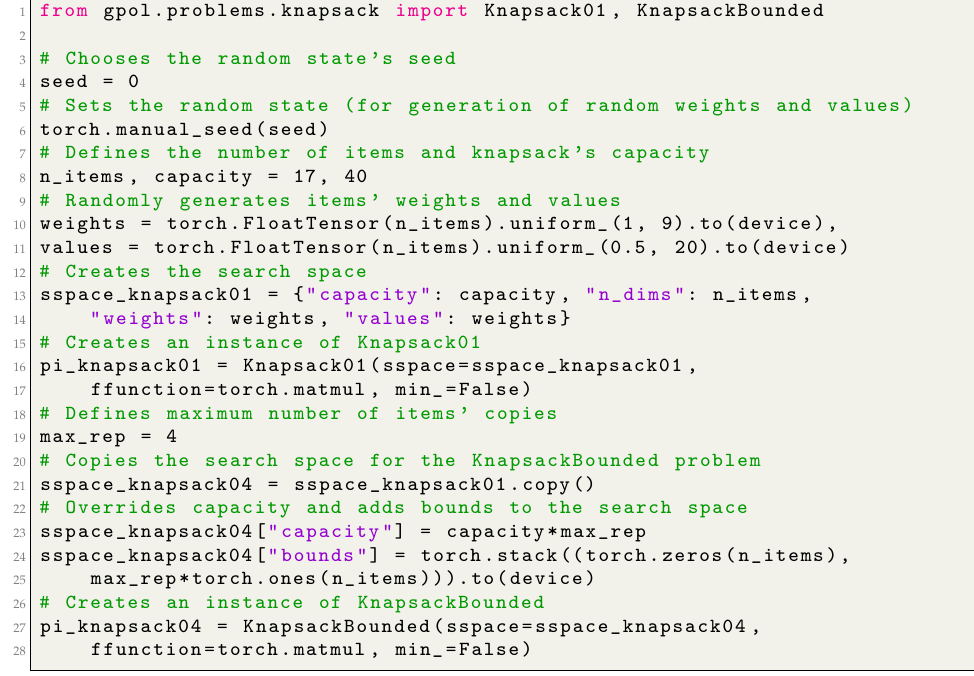
Figure A3. A demonstration of how to create instances of Knapsack01 and KnapsackBounded problems.